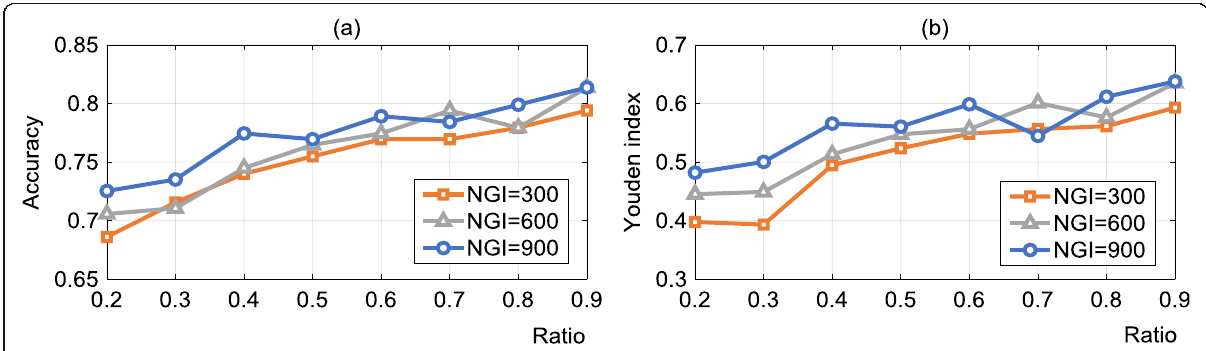
Fig. 10 a , b Influence of the ratio of categories on ZSAL. This shows the influence of the ratio of categories on ZSAL. NGI is the number of generated images. Youden index is a medical evaluation index. As the ratio of the demodicosis category increases, the accuracy and the Youden index increase. When the ratio of images containing demodicosis reached 0.9, the best evaluation index was